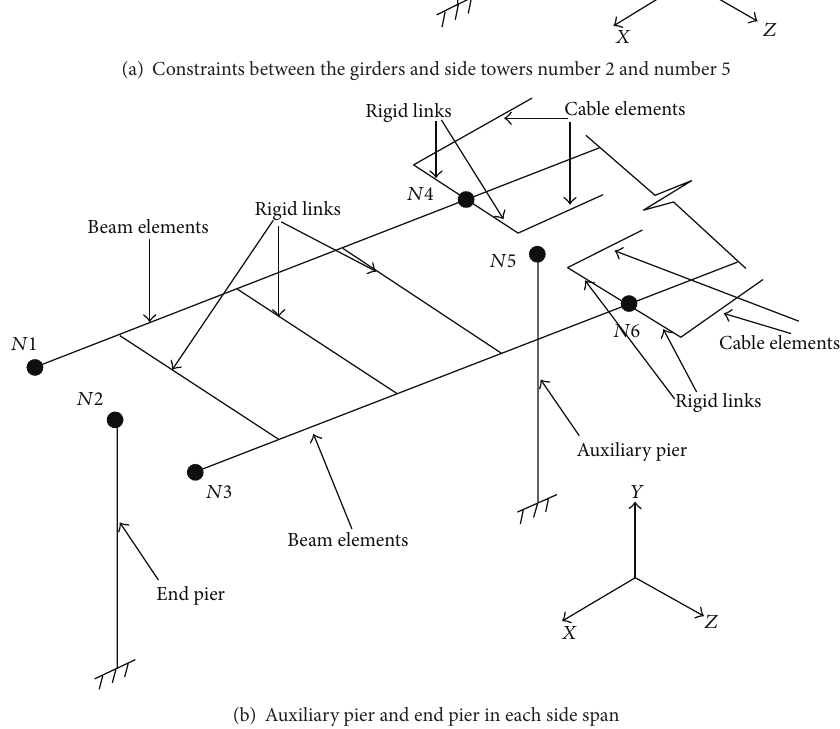
Figure 5: Detailed finite element modeling for the constraints between the girders and towers (piers). ROT 𝑋(𝑁1) = ROT 𝑋(𝑁2) = ROT 𝑋(𝑁3) , and ROT 𝑋(𝑁4) = ROT 𝑋(𝑁5) = ROT 𝑋(𝑁6)